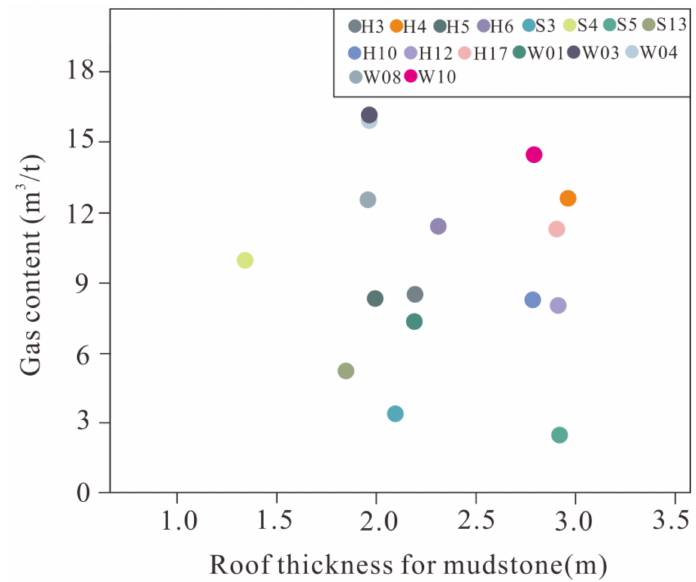
Figure 6. Relationship of roof thickness for mudstone and gas content of the No.5 coal seam in the Weibei